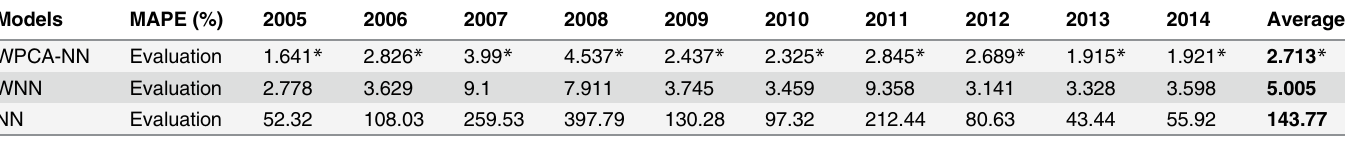
Table 11. Performance of the models, MAPE ratio of evaluation results for TAIEX futures. Models